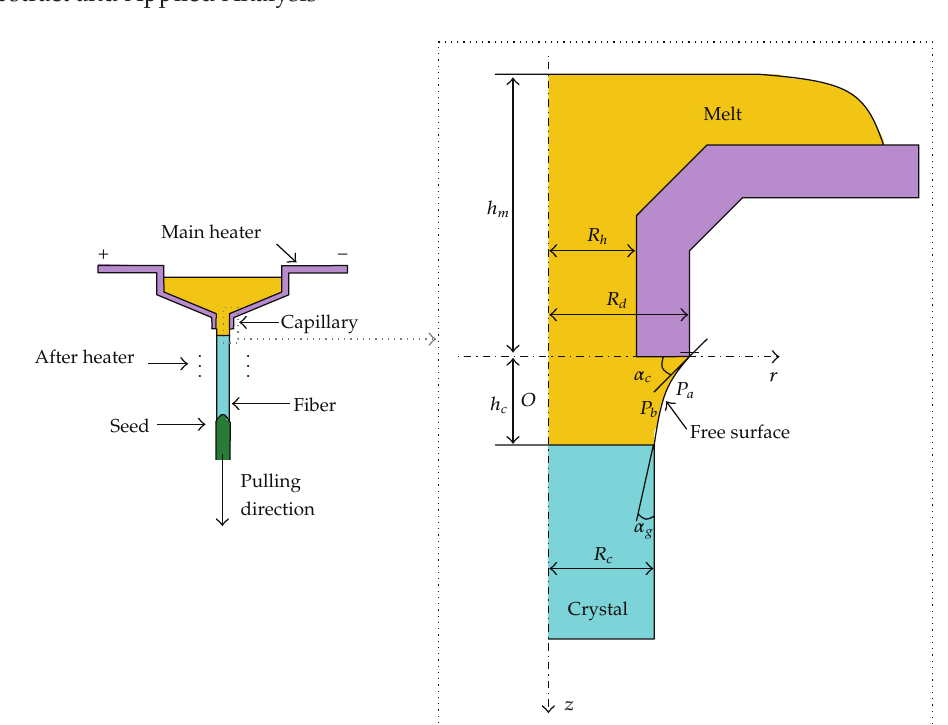
Figure 1: Schematic diagram of the μ -pulling-down fiber growth